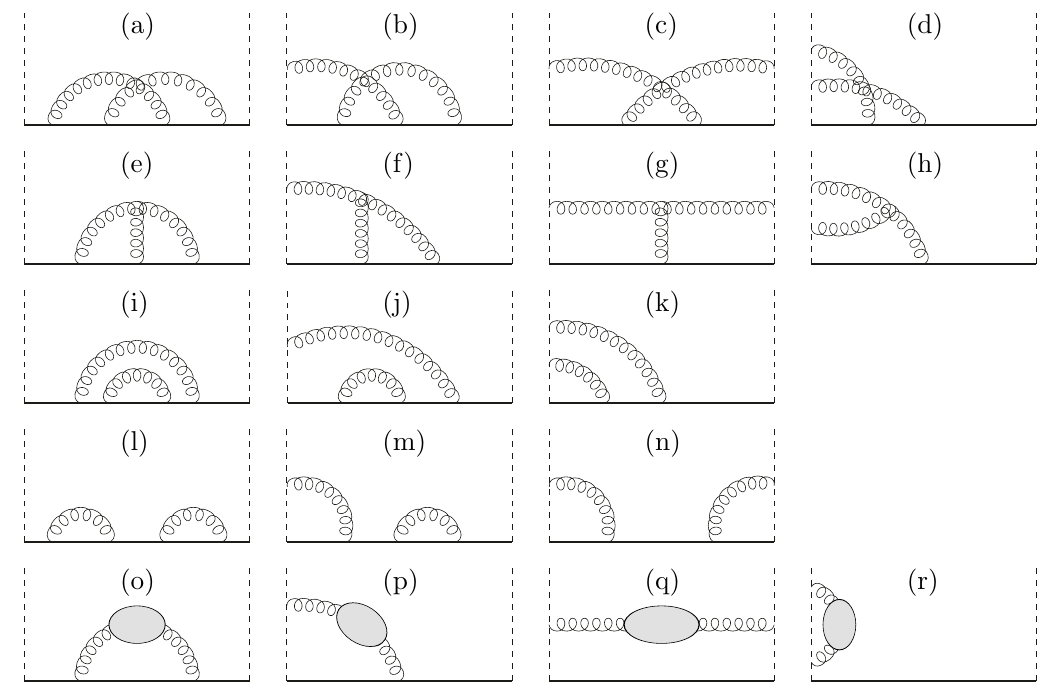
Figure 1 . QCD Feynman diagrams contributing to the jet (cid:12)eld correlator in eq. (2.4) at two-loop order in Feynman gauge. The dashed lines represent n -collinear (lightlike) Wilson lines. The gray blob symbolizes the set of all 1-loop gluon self-energy subdiagrams. Left-right mirror graphs are understood. Diagrams that are trivially zero (as (cid:22) n 2 = 0) are not shown. factor encodes the full s dependence in the massless limit ( s ! p 2 ), where I becomes